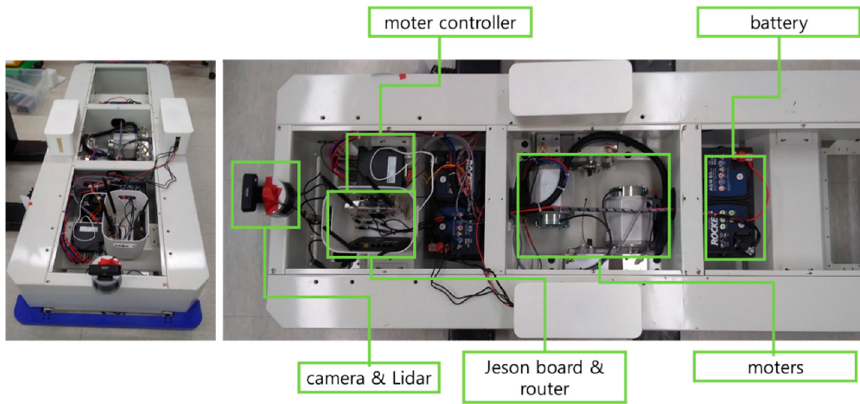
Figure 10. Agriculture mobile robot.